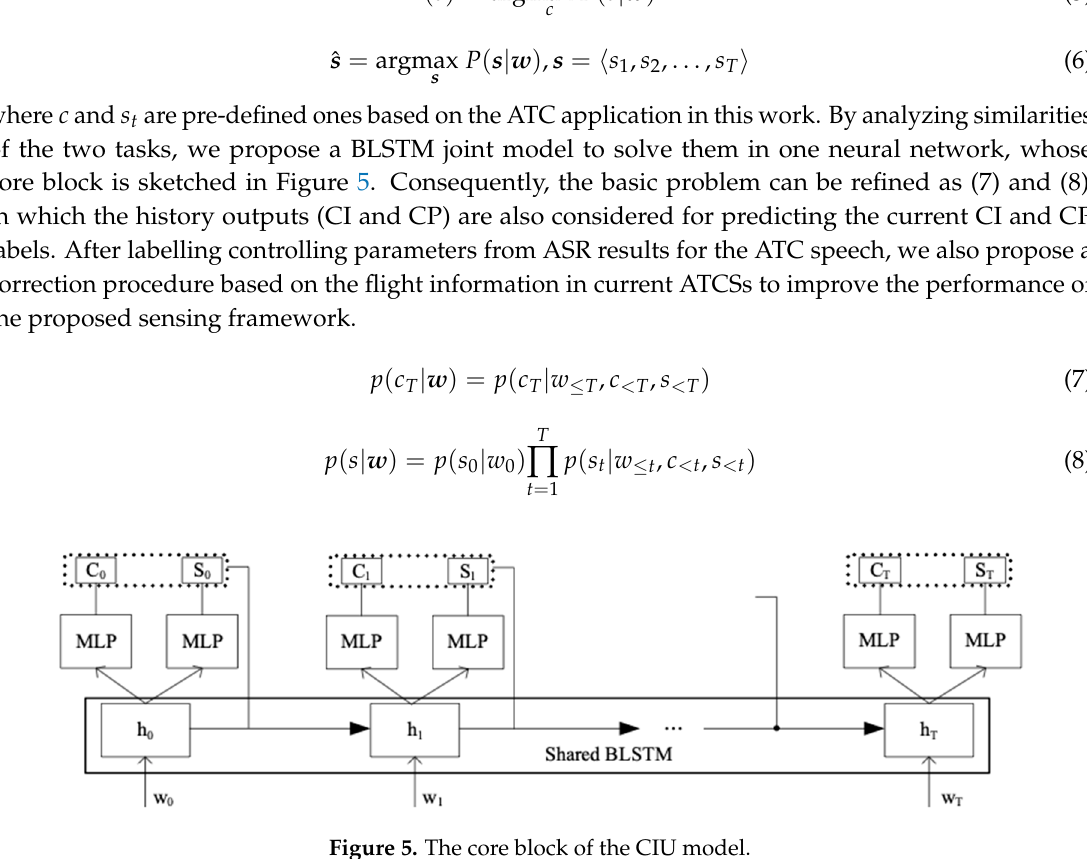
Figure 5. The core block of the CIU model.